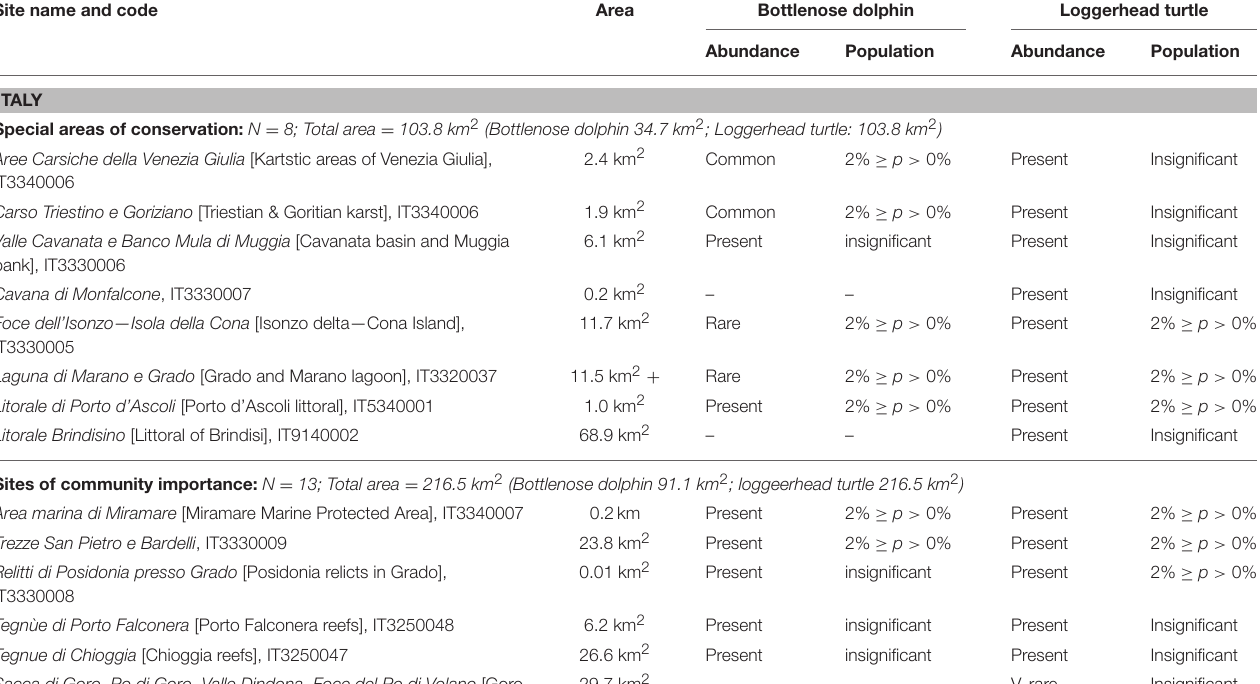
TABLE 1 | Adriatic Sea Natura 2000 sites listing the bottlenose dolphin and the loggerhead